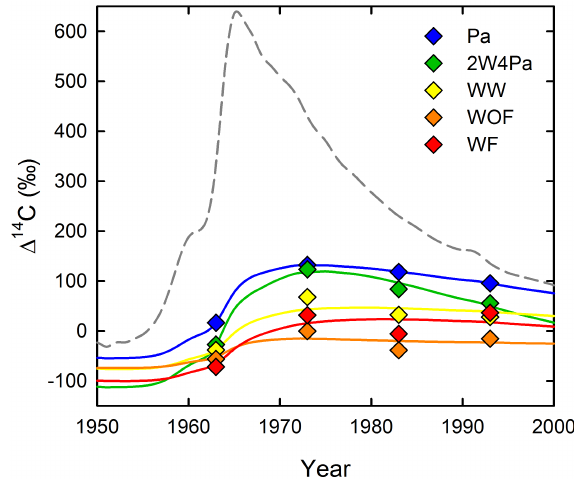
Figure 3. (cid:49) 14 C values of soil organic carbon in upper 10cm along with yearly output from the best-fit bomb-spike model so- lutions for scenario 1 (curve fits for scenario 2 shown in Fig. C1 in Appendix C) where the allocation of C to pools was fixed us- ing the estimated fractions from MIR-PLSR analysis and the model was solved for k values. Southern Hemisphere atmospheric 14 CO 2 record is shown for reference (dashed